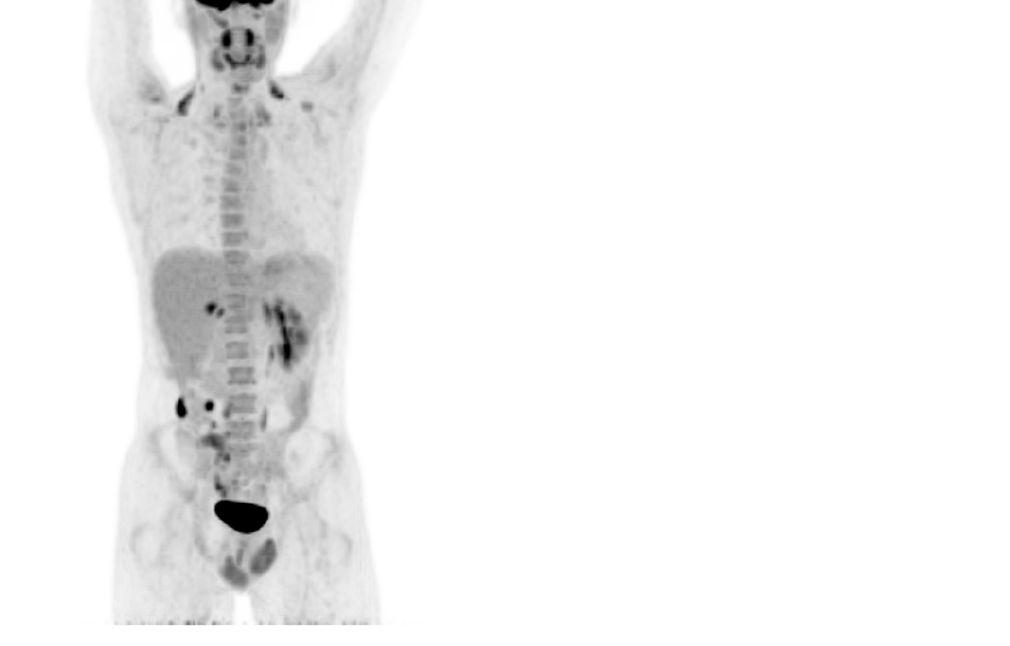
Figure 3. PET-CT confirming first progression, with locoregional lesions, hepatic and retroperitoneal metastasis.